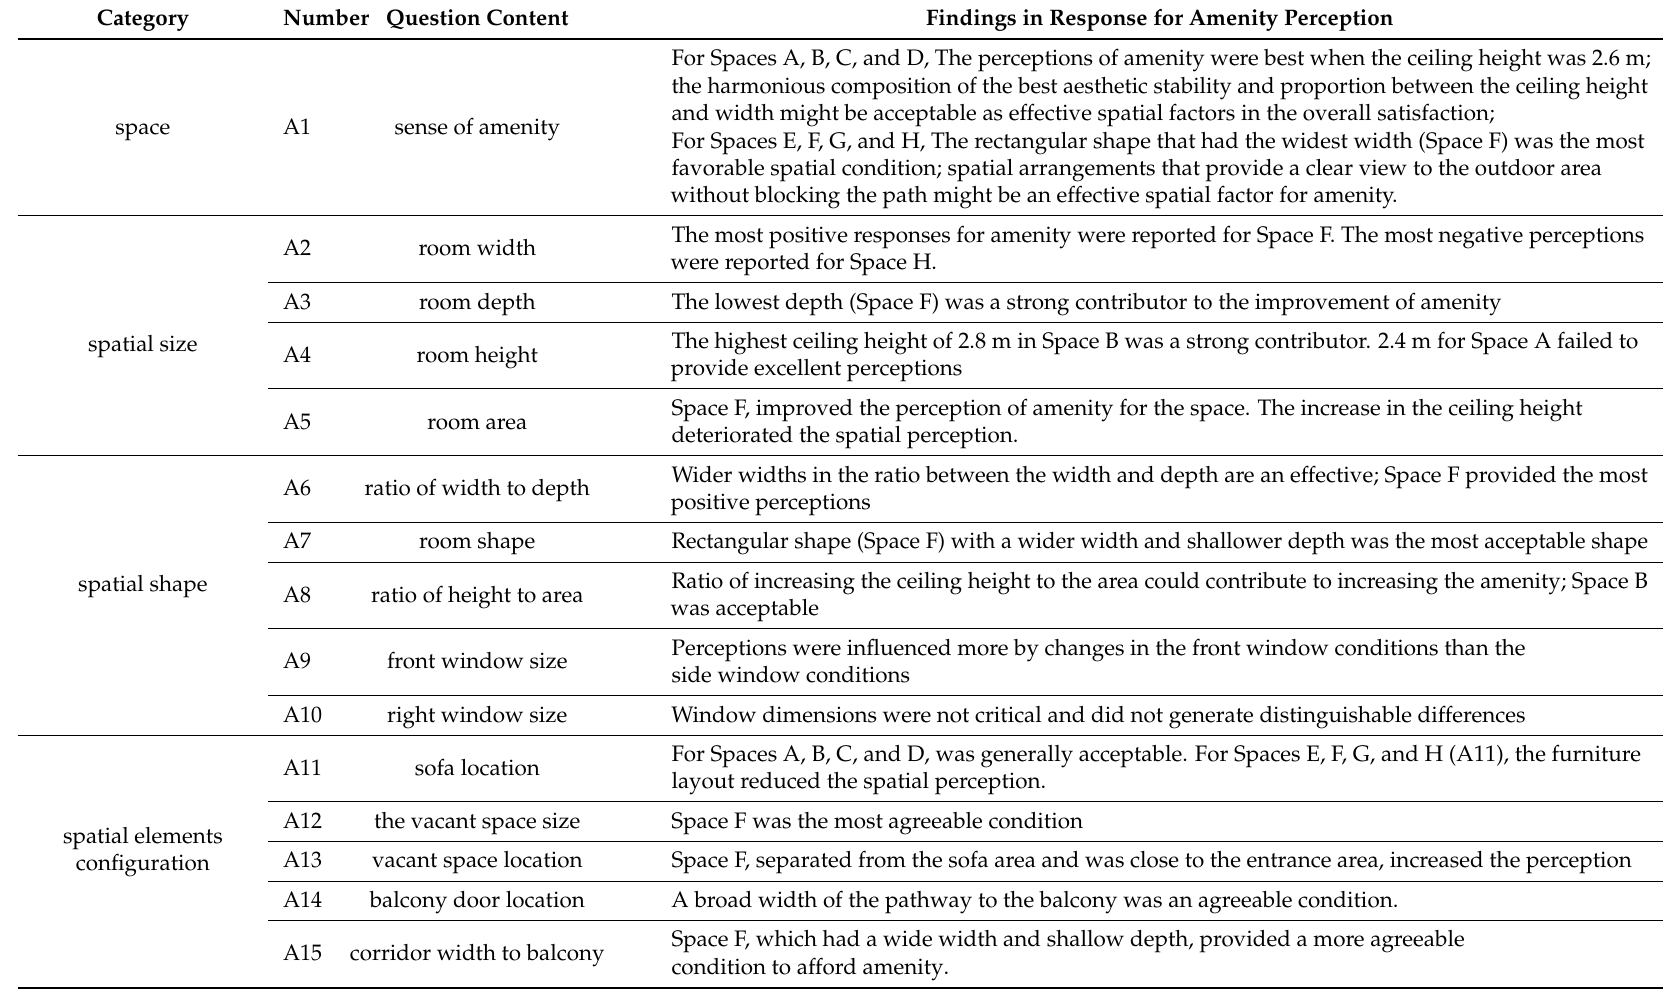
Table 5. Responses for amenity